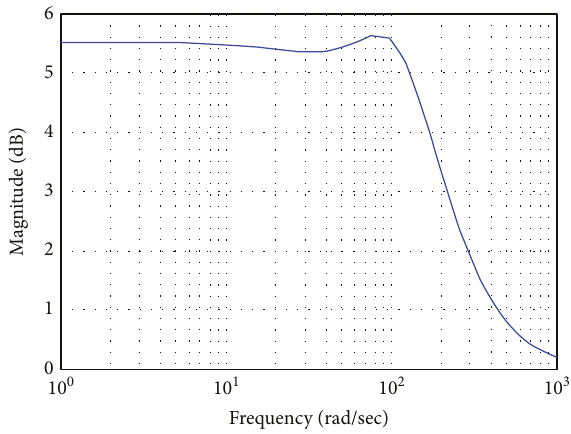
Figure 11: The Bode plot of S j ω .